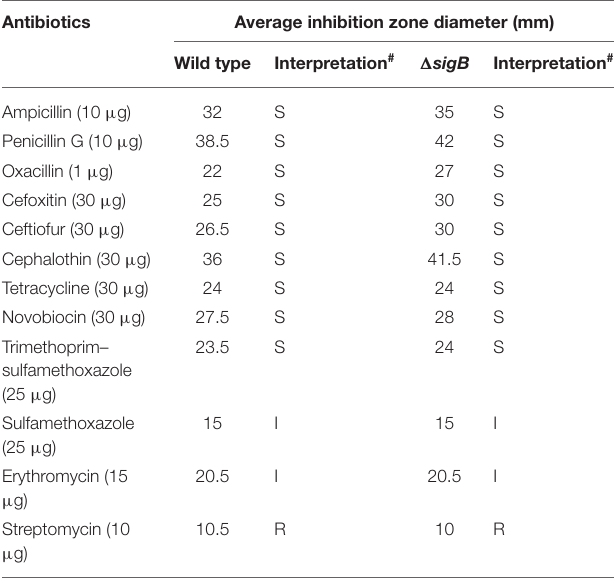
TABLE 2 | Antibiotic susceptibility test of wild type and 1 sigB strain. Antibiotics Average inhibition zone diameter